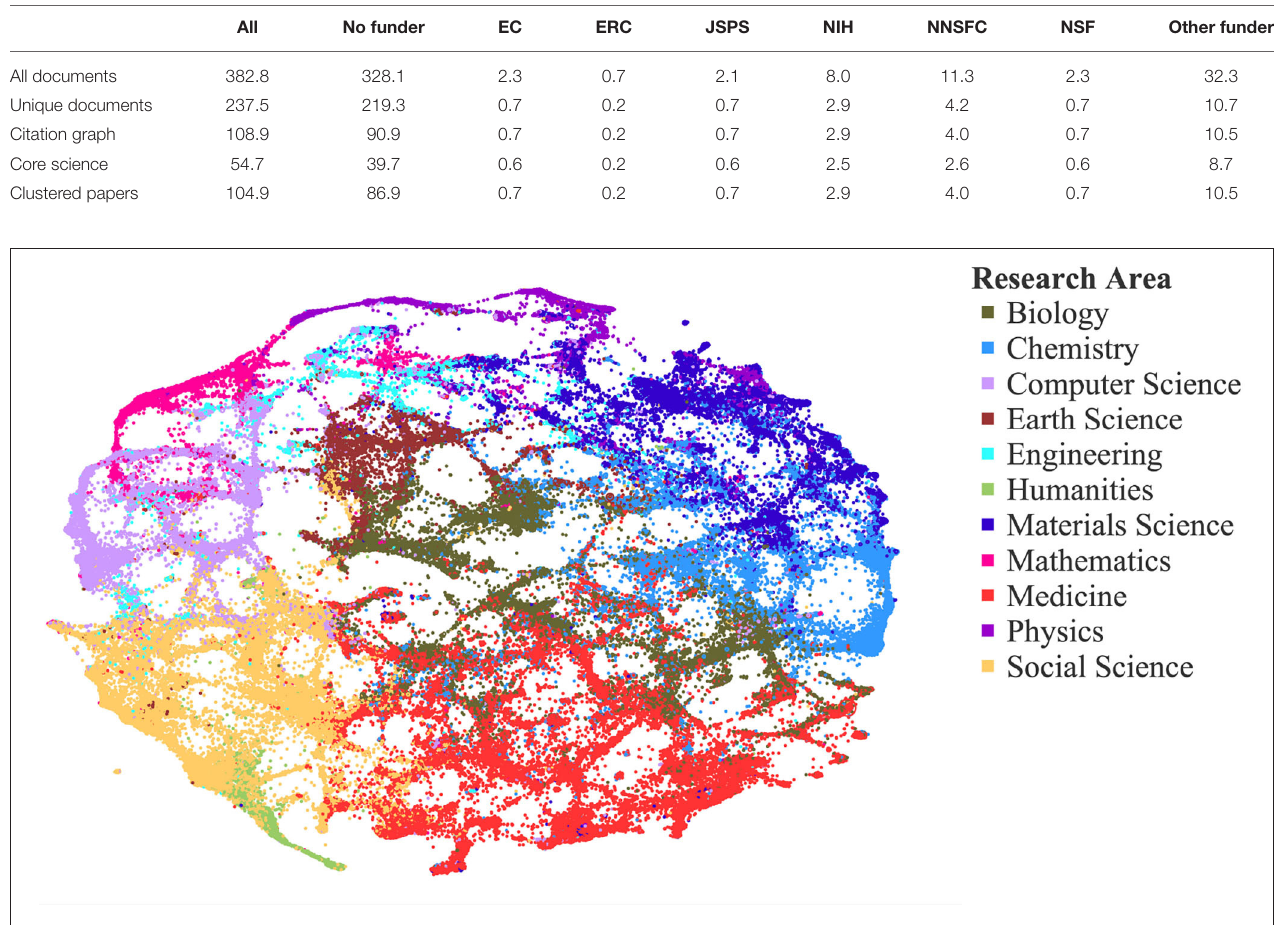
FIGURE 4 | Map of science: 126,915 active research clusters (RCs) creating an inferred structural basis for analysis from direct citation links between tens of millions of articles across four data